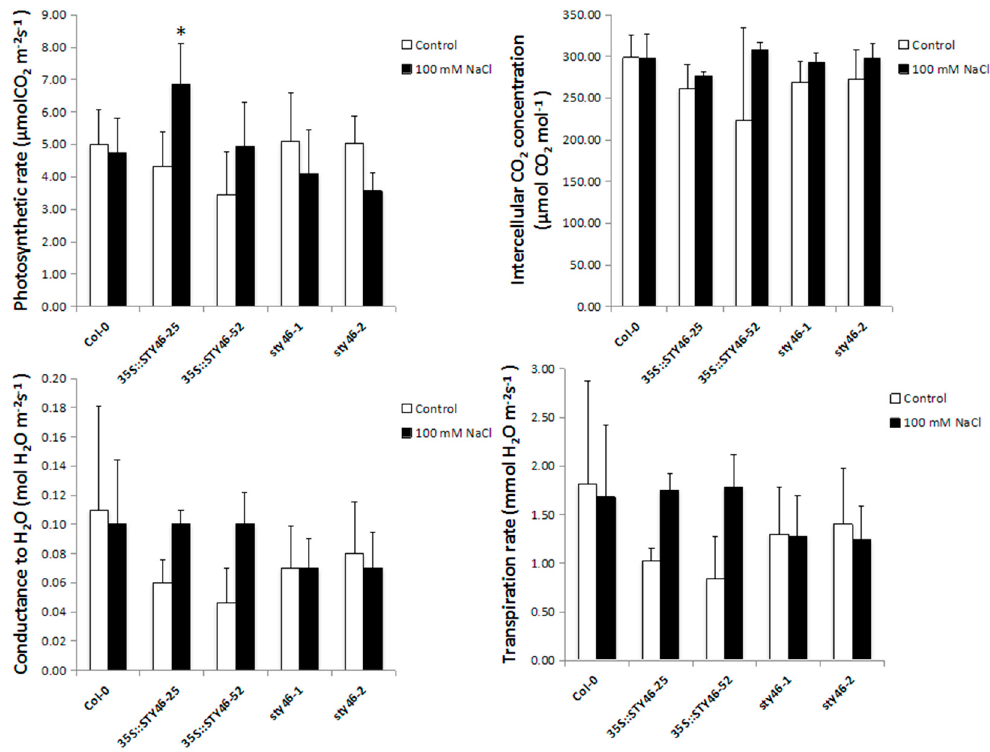
Figure 7. Photosynthetic performance of STY46 transgenic lines under control conditions and salinity stress. The transgenic lines were exposed to 100 mM NaCl for one week and the photosynthetic rate, water conductance, intercellular CO 2 concentration, and transpiration rate were measured. The asterisks indicate statistically significant differences between transgenic lines and the wild type control ( n = 5, p < 0.05).